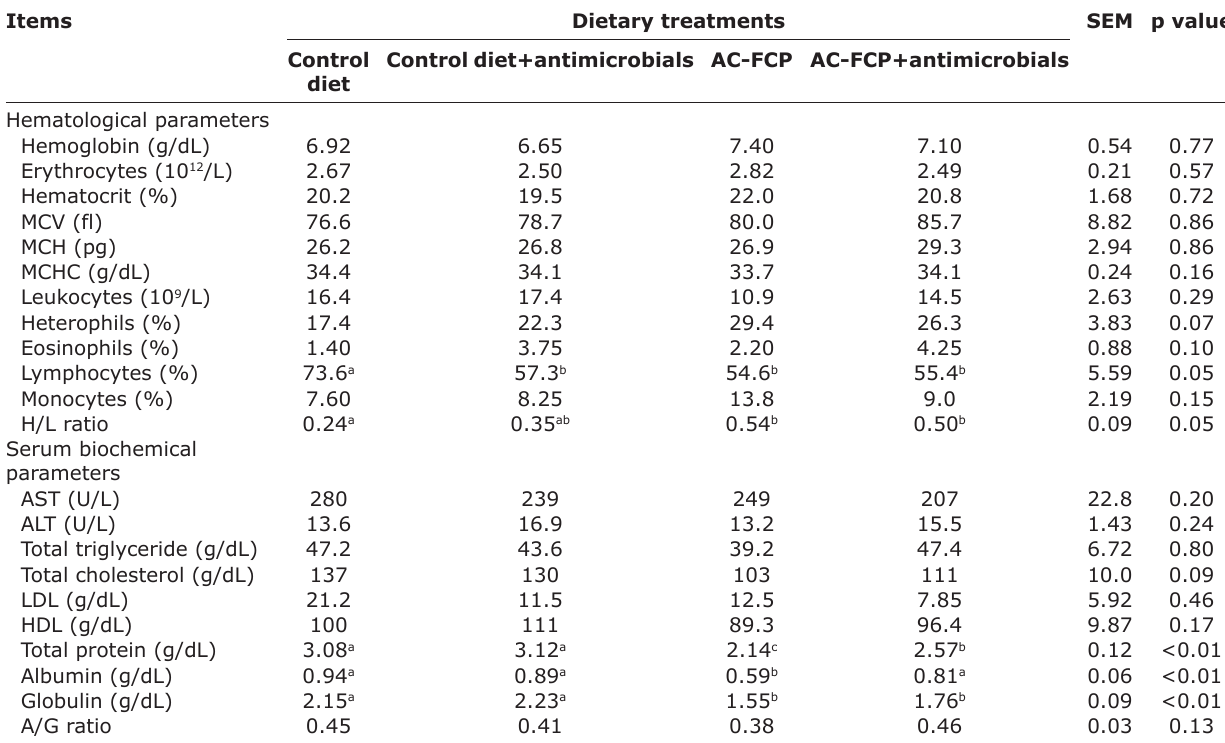
Table-4: Hematological and biochemical parameters of broilers fed the treatment diets. Items Dietary